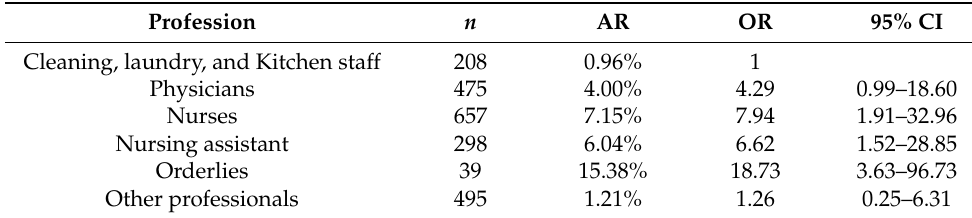
Table 1. Attack rate in health care workers.